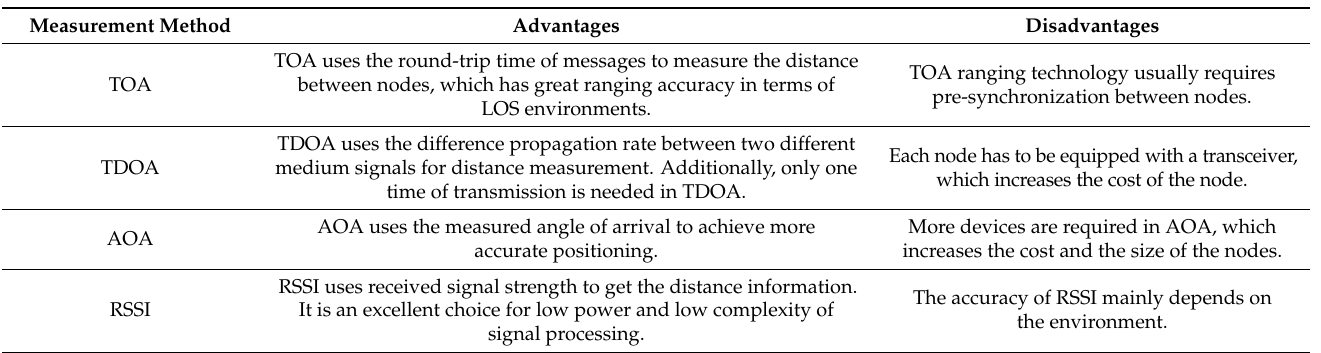
Table 1. The advantages and disadvantages of TOA, TDOA, AOA, and RSSI. Measurement Method Advantages